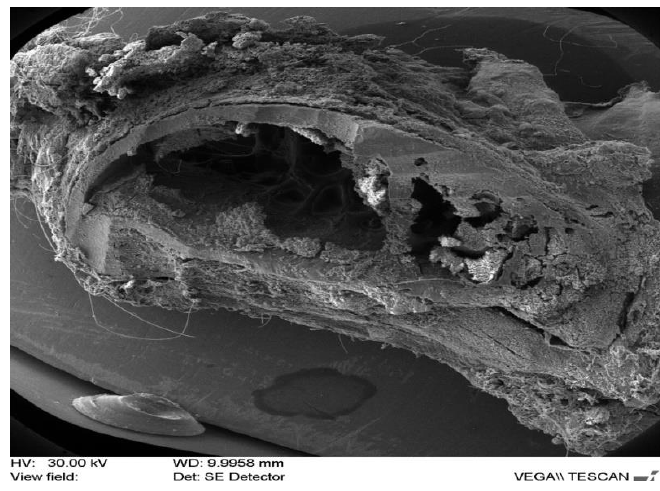
Figure 7. Presence of a Howship Gap in which typical osteoclasts with a brushed edge that attach to excess, newly formed dense material (MTA).